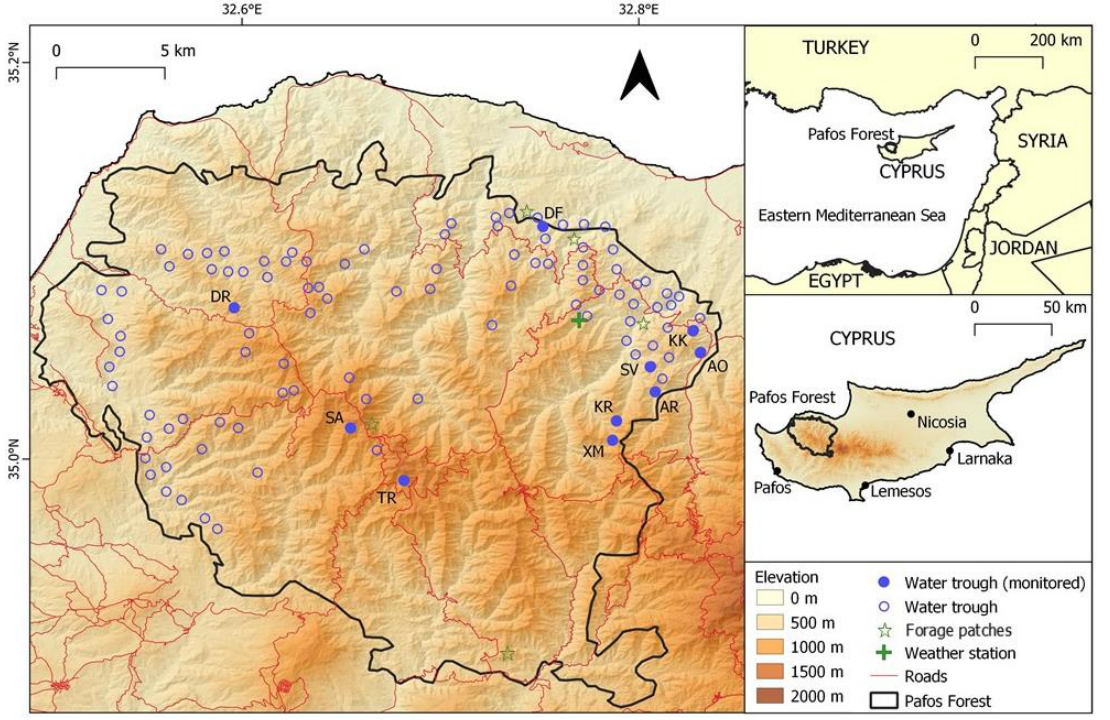
Figure 1. Map of the Pafos Forest area where the network of water thoughts was established for the watering of Cyprus mouflon. (DR: Dromonas; SA: Selladi Arnion; TR: Tripilos; DF: Den of Fox; SV:Selladi Voullas; KK:Kokinokremmos; AO:Apo Orkontas; AR: Artratsa; XM: Xeromoutas; KR: Koriftos)